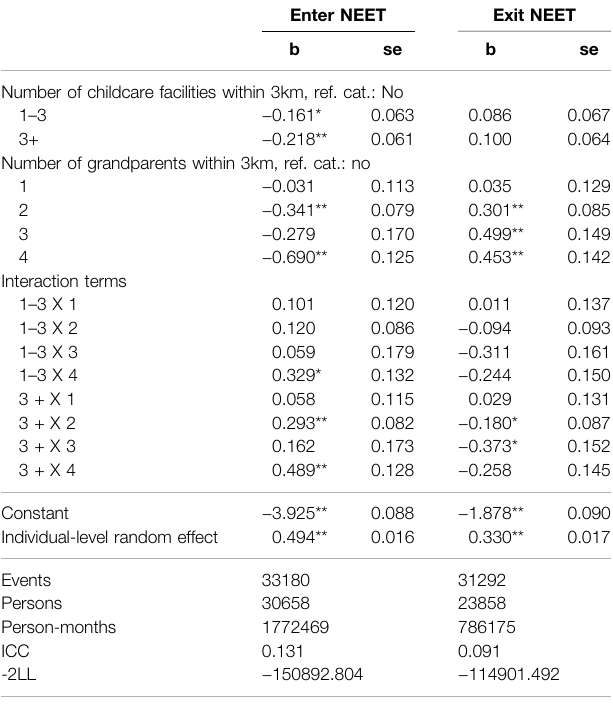
TABLE 6 | Discrete-time event history analysis of formal childcare availability measured as interacted with availability of informal childcare, logistic regression of entry into and exit out of